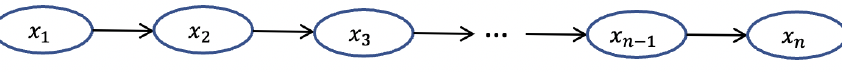
Figure 4. The structure of Markov chain.